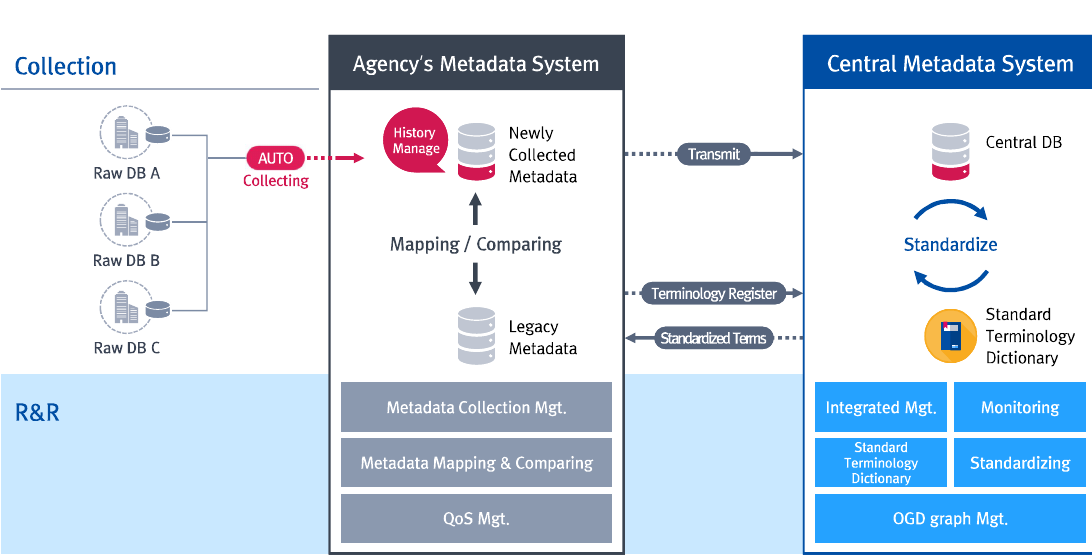
Figure 2. Automatic Metadata Collection by Agency Types.